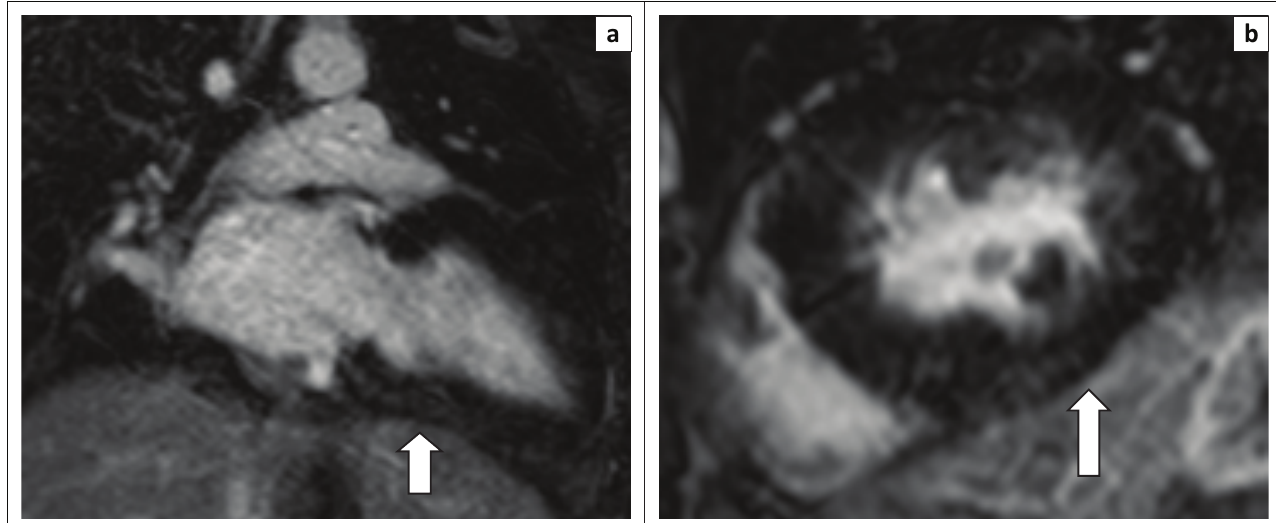
FIGURE 6: Hypertrophic cardiomyopathy. Two-chamber (left) and short-axis (right) late gadolinium images demonstrate diffuse enhancement of the thickened myocardium